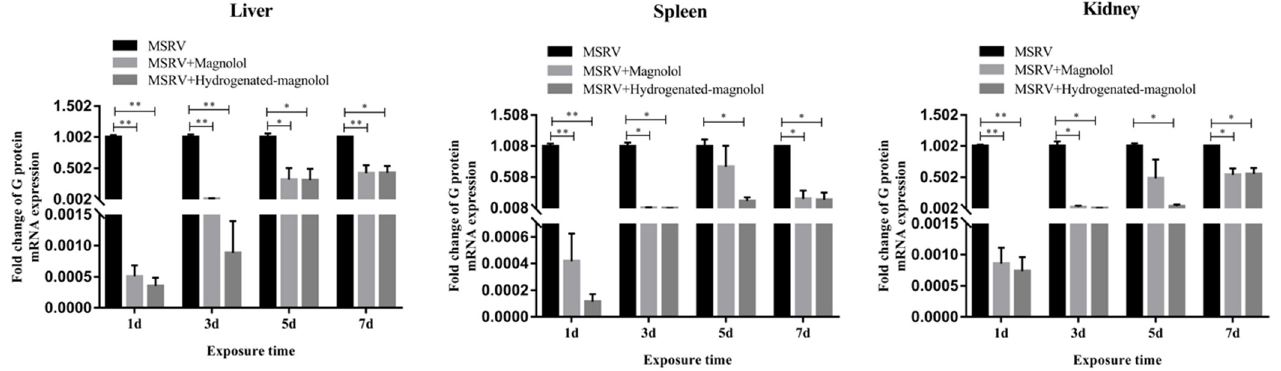
Figure 9. Expression of MSRV G gene in liver, spleen, and kidney after injection with MSRV and magnolol/hydrogenated magnolol (20 mg/kg). Each value represents the mean ± SEM. ** p < 0.01, * p < 0.05.